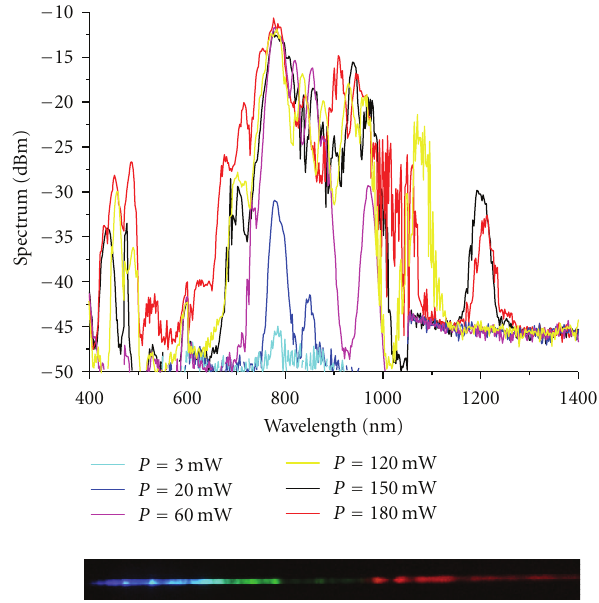
Figure 9: Experimental spectra for a 25-cm-long PCF versus wavelength at 785 nm. The SC is generated by the first high-order mode